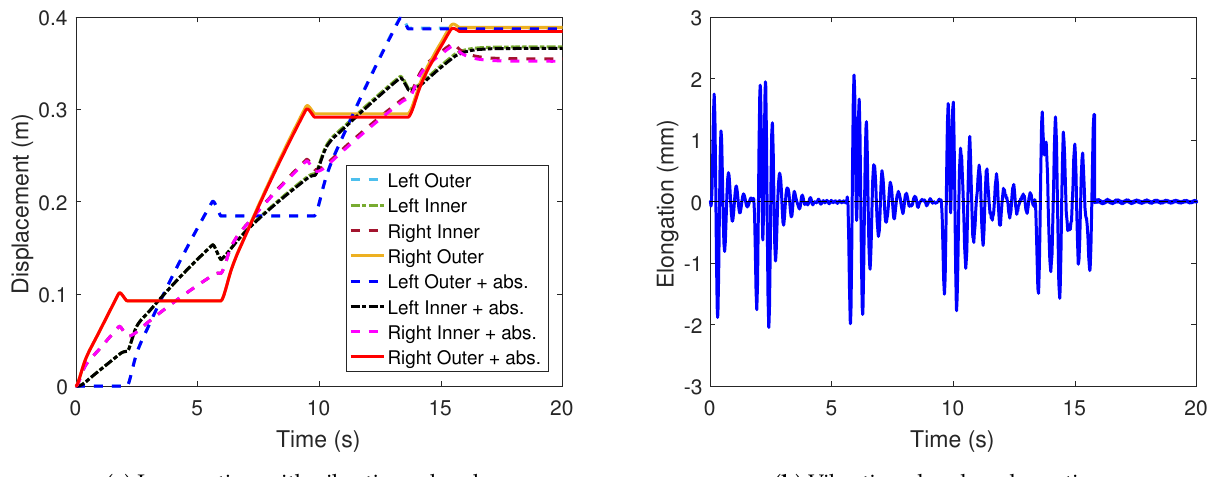
Figure 11. Wheels displacement and absorber elongation during human-like locomotion using the dynamic